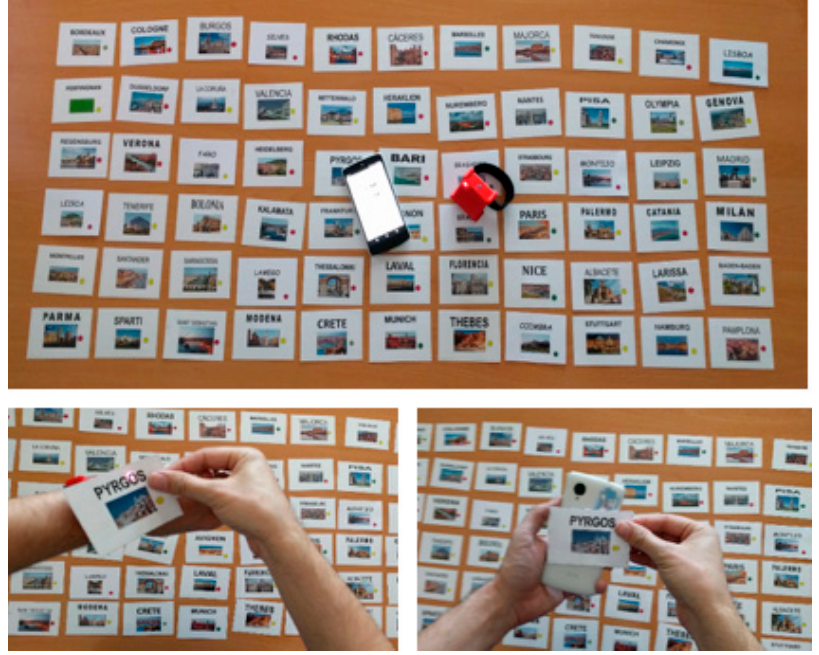
Figure 14. MovED usability evaluation.